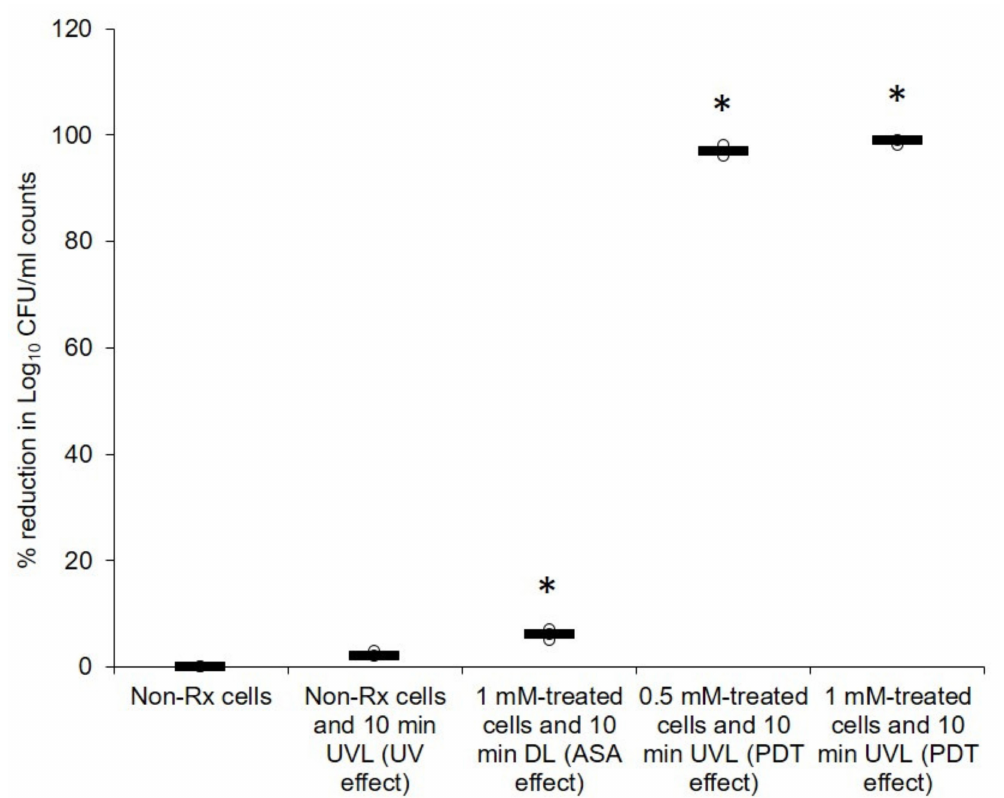
Figure 2. Effect of PDT with ASA on the survival of C. neoformans LMPE 046. Non-Rx, non-treated cells; UVL, ultraviolet light; DL, dark light; CFU, colony-forming unit. Data points were obtained from three biological replicates for each defined experimental condition. * Significantly different from non-Rx cells at p <